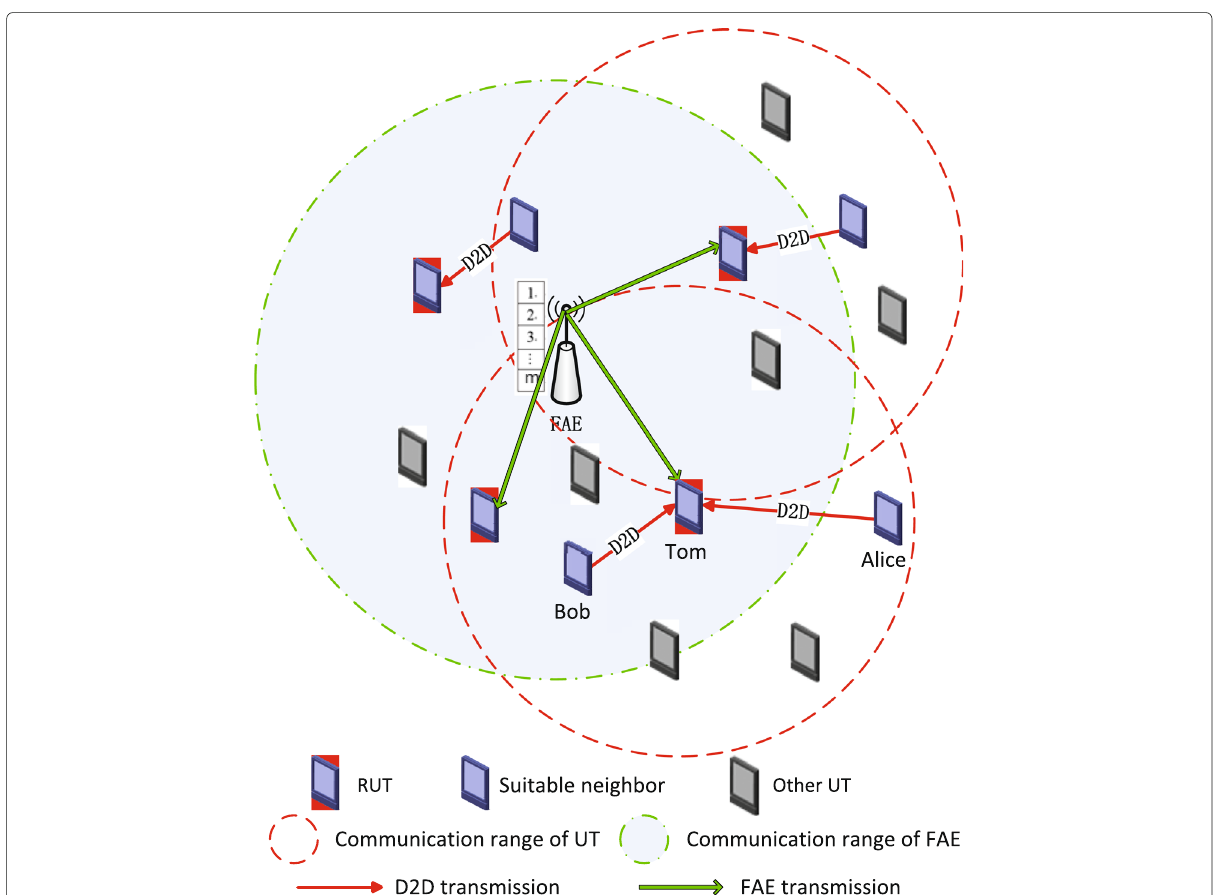
Fig. 3 Cooperation D2D communication for cache-driven multi-source caching model under MRT and ZFBF. This figure illustrates a